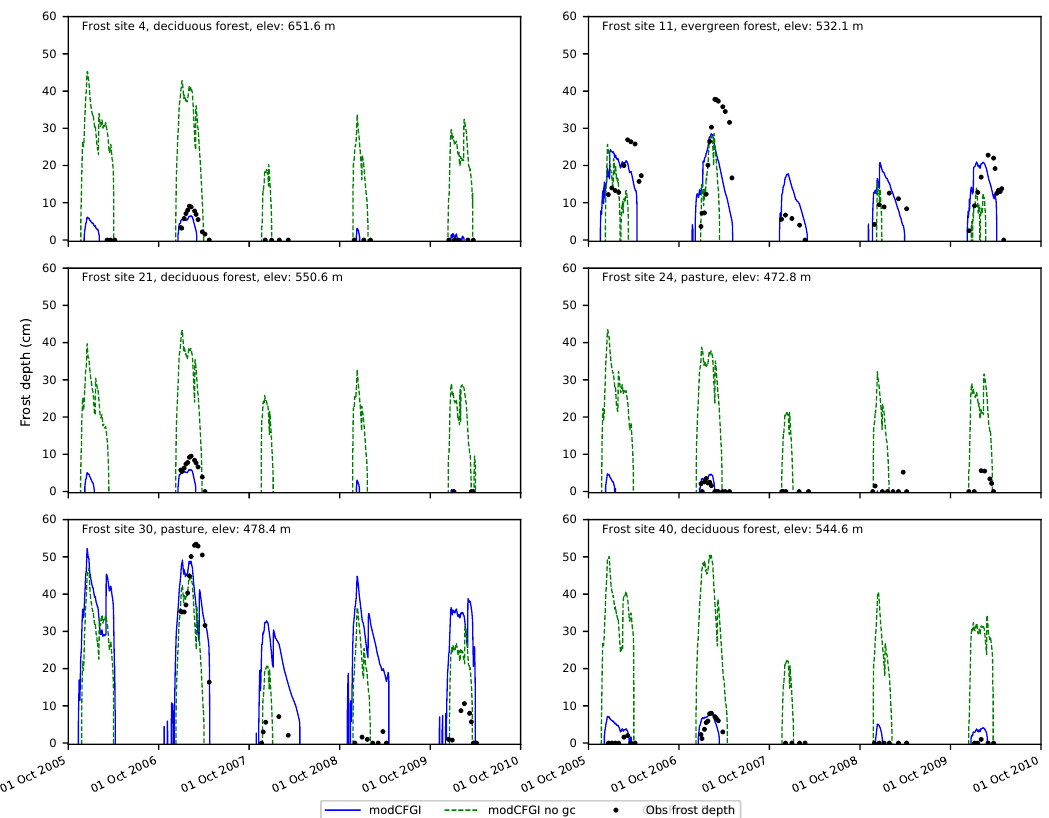
Figure 8. Observed frost depth compared against simulated (modCFGI with and without ground cover included) frost depth at all six selected frozen ground test sites within the W-3 watershed. The modCFGI model without ground cover is labeled as ”modCFGI no